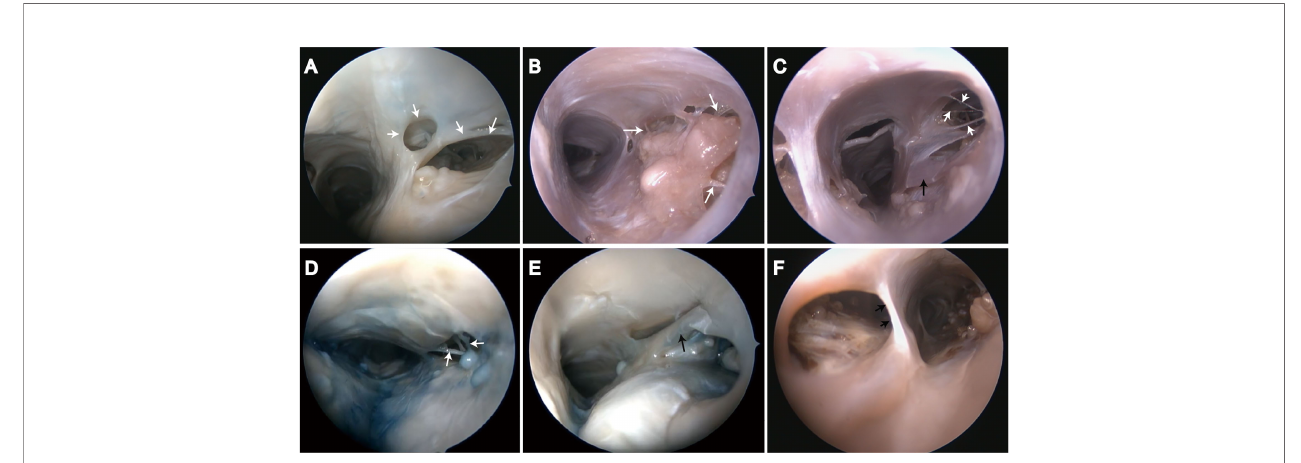
FIGURE 4 | Endoscopic view of chordae willisii around arachnoid granulation in the superior sagittal sinus. (A) Valvelike chordae (white arrow); (B – D) Trabecular chordae (white arrow); (E, F) Longitudinal lamellae (black arrow).